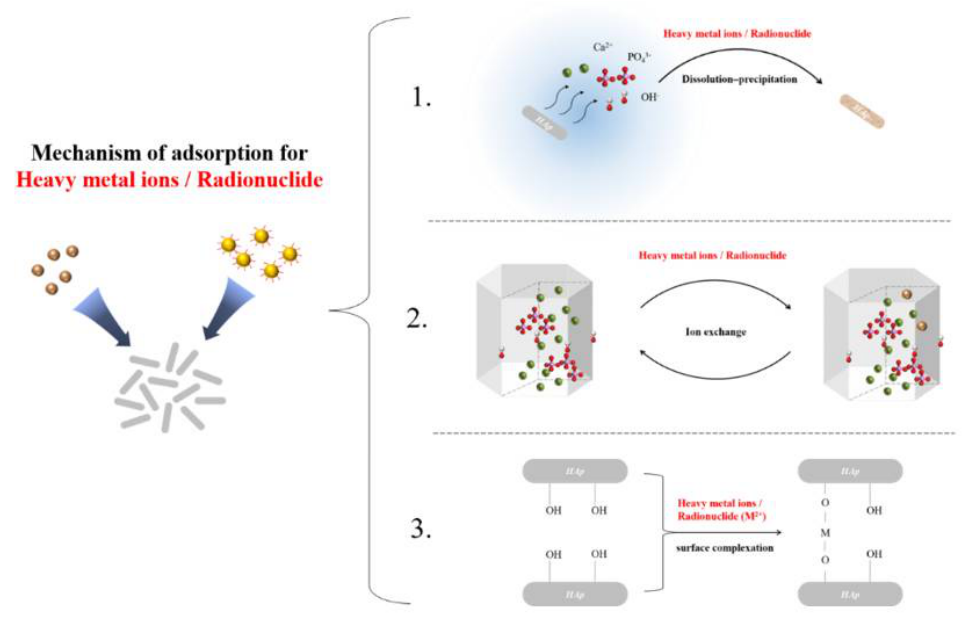
Figure 2. Adsorption mechanism of HAp for heavy metal ions or radionuclide.